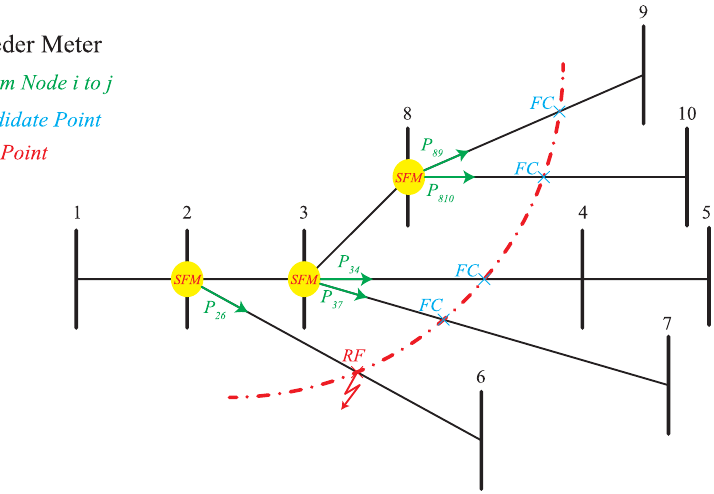
Figure 3. A sample network equipped with SFMs located in nodes 2, 3, and 8.